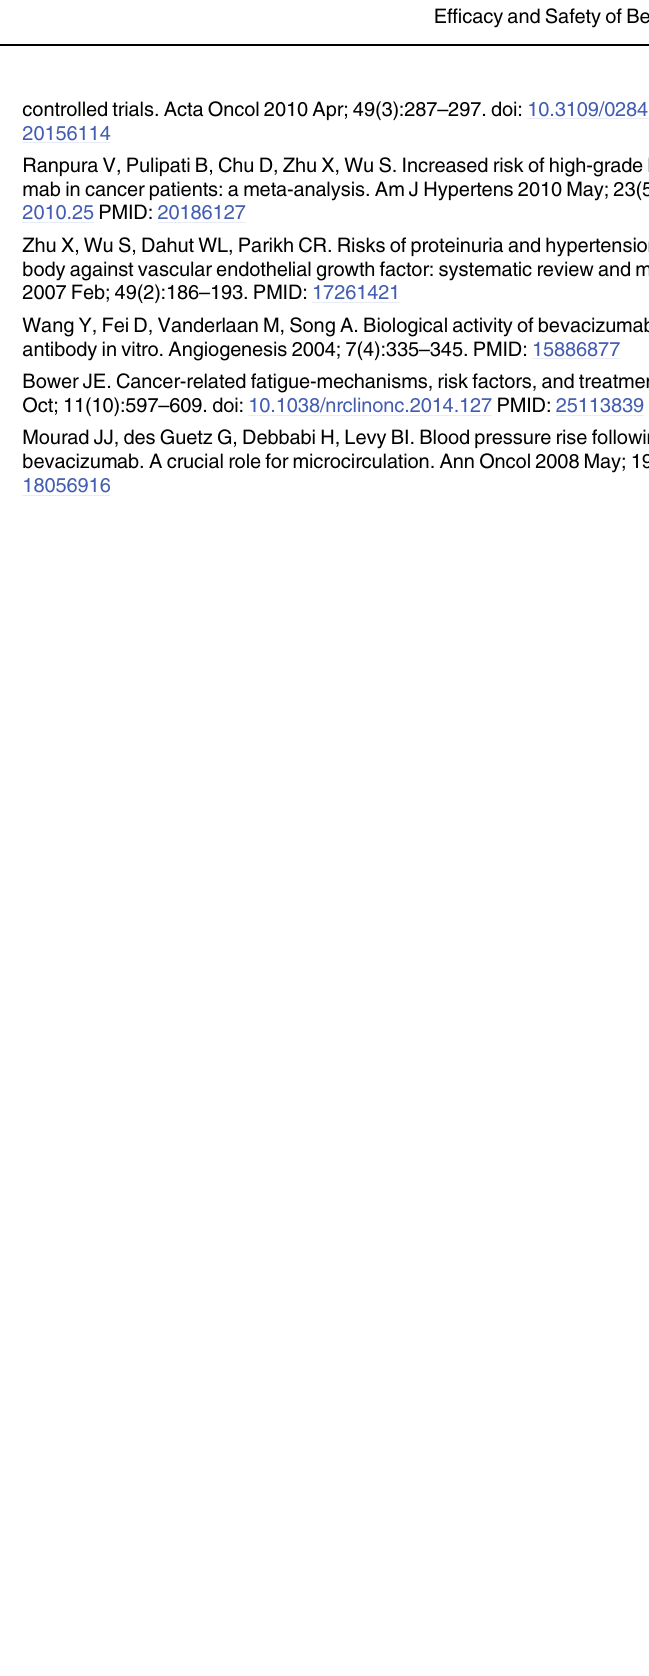
PLOS ONE | DOI:10.1371/journal.pone.0136324 September 2,